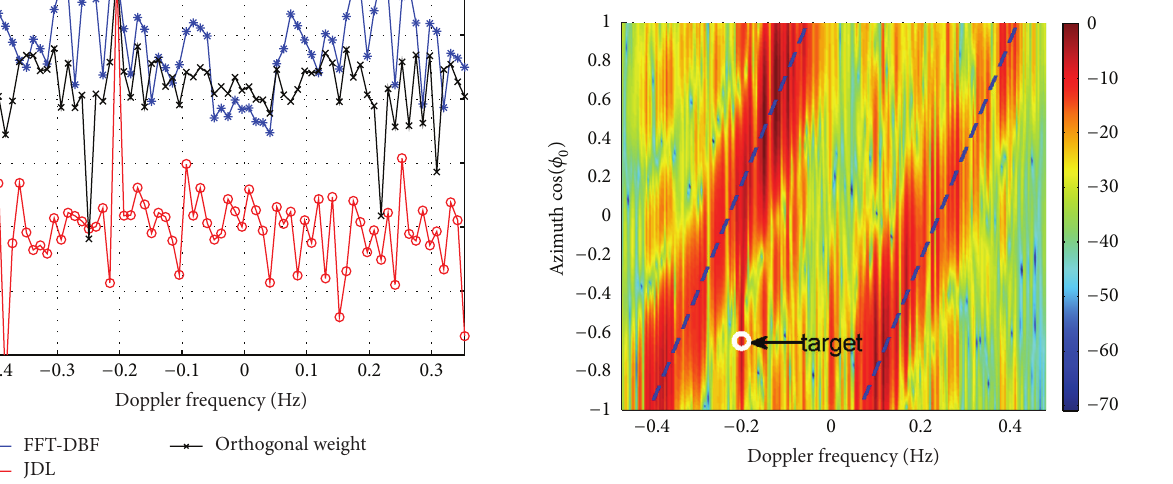
Figure 6: Compared Doppler results (simulated sea clutter, target azimuth 95 ∘ ).